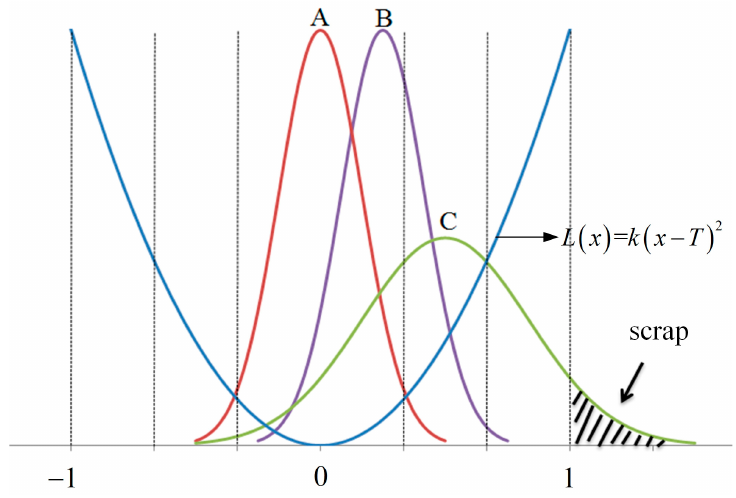
Figure 1. Process loss distribution chart.